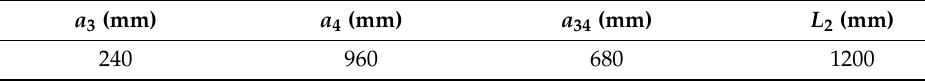
Table 1. Structural parameters of high-pressure rotor system.